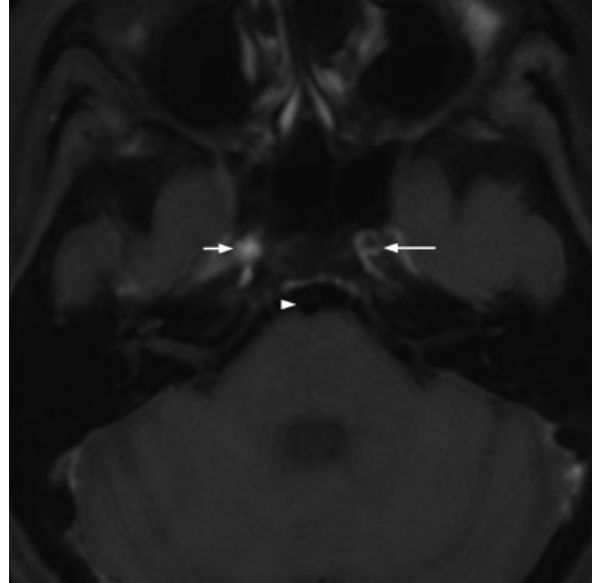
Fig. 5 T1 black-blood post-gadolinium imaging sequence MRI showing normal basilar artery ( arrowhead ), left ICA in the cavernous segment with vessel wall enhancement (VWE, long arrow ) and oc- cluded right ICA with hyperintense thrombus ( short arrow ). ICA, internal carotid